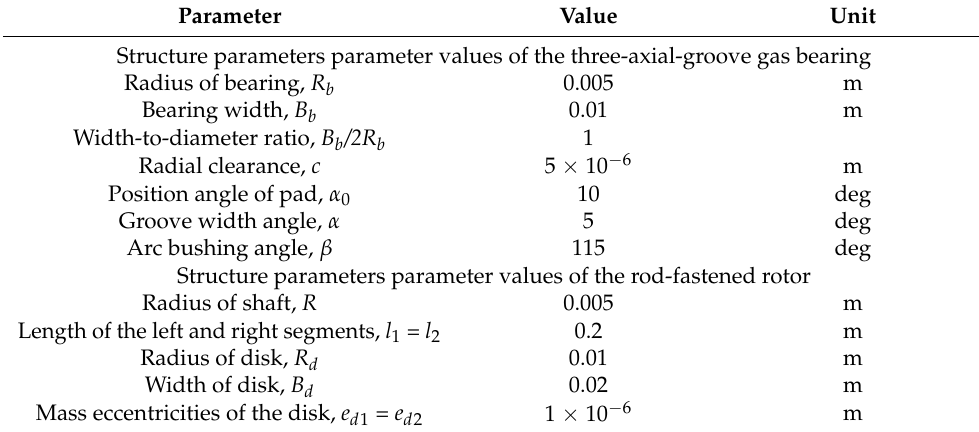
Table 2. Structure parameter values of the rod-fastened rotor-gas bearing system. Parameter Value Unit Structure parameters parameter values of the three-axial-groove gas bearing Radius of bearing, R b 0.005 m Bearing width, B b 0.01 m Width-to-diameter ratio, B b /2R b 1 Radial clearance, c 5 × 10 − 6 m Position angle of pad, α 0 10 deg Groove width angle, α 5 deg Arc bushing angle, β 115 deg Structure parameters parameter values of the rod-fastened rotor Radius of shaft, R 0.005 m Length of the left and right segments, l 1 = l 2 0.2 m Radius of disk, R d 0.01 m Width of disk, B d 0.02 m Mass eccentricities of the disk, e d 1 = e d 2 1 × 10 − 6